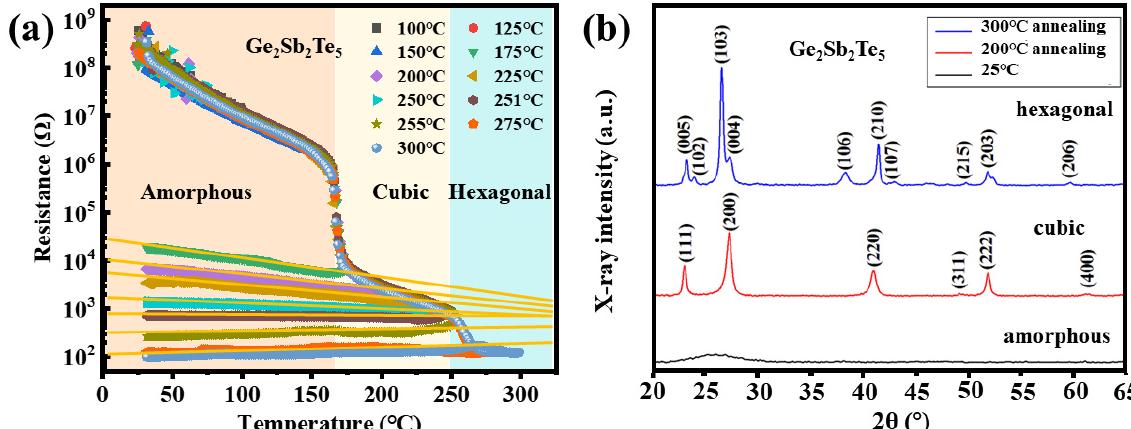
Figure 1. ( a ) The resistance–temperature curves of GST films annealed from 100 °C to 300 °C. ( b ) XRD patterns at 25 °C, 200 °C, and 300 °C, respectively.